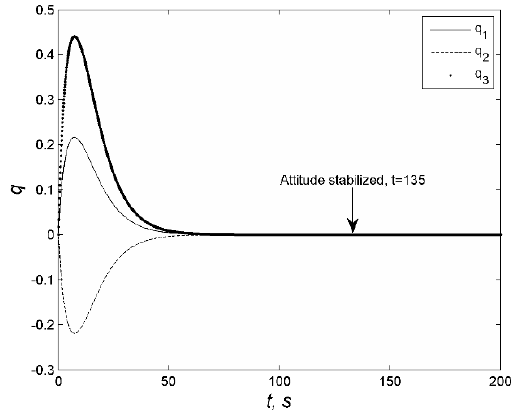
Figure 5. Relative quaternion with respect to the target.